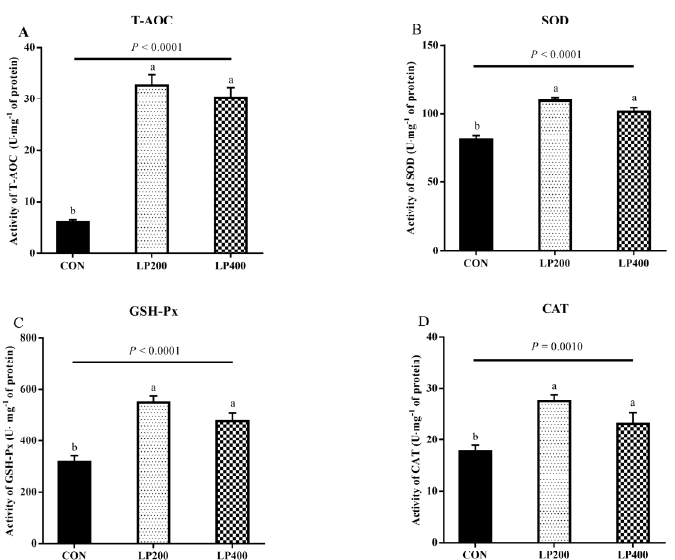
Figure 2. Effect of dietary lycopene supplementation on activities of antioxidant enzymes (on day 0)—total antioxidant capacity (T ‐ AOC) ( A ), superoxide dismutase (SOD) ( B ), glutathione peroxi ‐ dase (GSH ‐ Px) ( C ) and catalase (CAT) ( D ) ( n = 10). Different lowercase letters denote significant differences ( P < 0.05) among treatments. The error bars represent standard error. CON, control group; LP200 and LP400 mean 200 or 400 mg ∙ kg − 1 lycopene powder supplementation in the con ‐ trol diet, respectively.